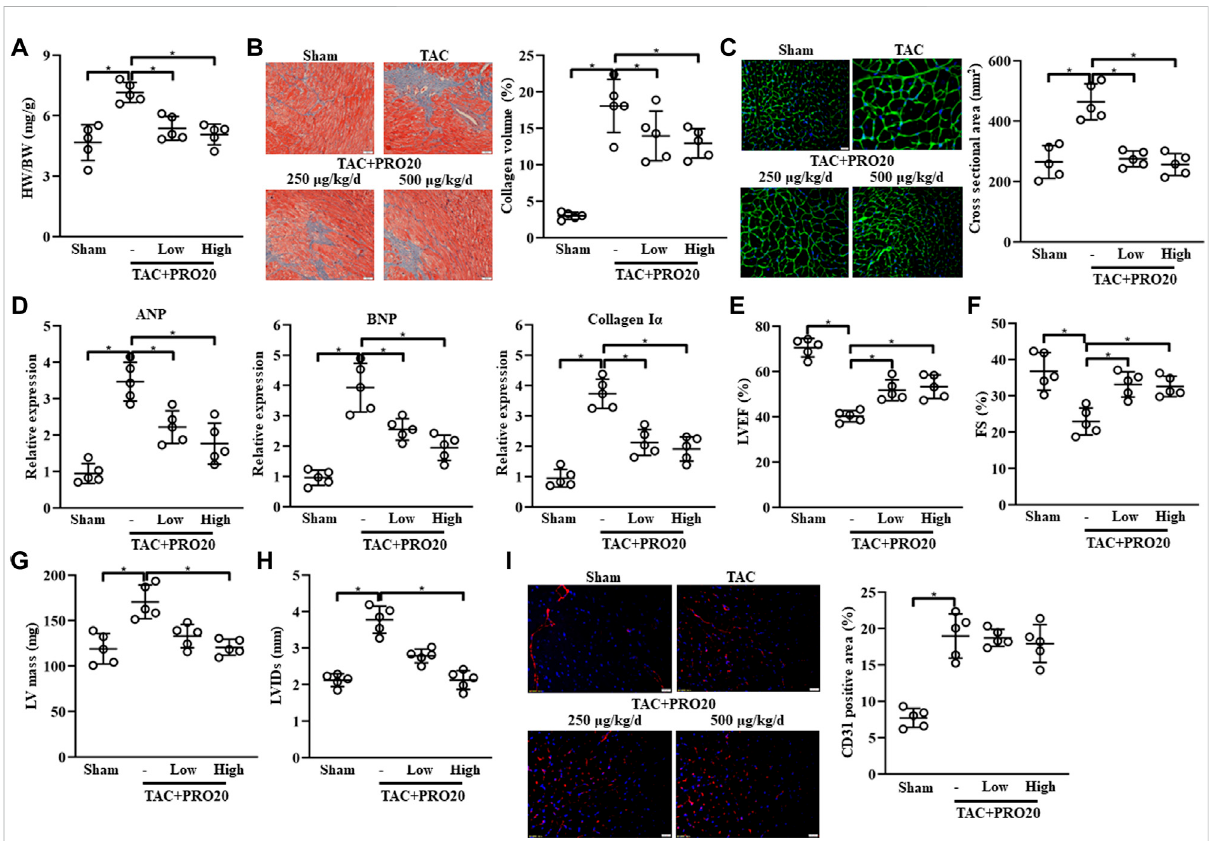
FIGURE 2 PRR decoy inhibitor PRO20 ameliorates HF in mice after 8 weeks of TAC surgery. (A) The ratios of heart weight and body weight (HW/BW) in TAC-inducedmice with and withoutPRO20 treatment for 8 weeks (250 μ g/kg/d and 500 μ g/kg/d). (B) Representative images of Masson staining of heart sections from TAC-induced mice and quantitative analysis of cardiac fi brosis. (C) Representative images of wheat germ-agglutinin (WGA) staining of heart sections from TAC-induced mice and quantitative analysis of cardiac hypertrophy. (D) Relative mRNA expression of cardiac hypertrophy markers (ANP and BNP) and Collagen I α in TAC-induced hearts with and without PRO20 treatment. (E – H) Echocardiographic analyses of left ventricular ejection fraction (LVEF), fractional shorting (FS), left ventricular mass (LV mass) and left ventricular internal diameter at end-systole (LVIDs)after8weeksofTACoperation. (I) RepresentativeimagesofCD31stainingofheartsectionsfromTAC-inducedmiceandquantitativeanalysis of angiogenesis. p p -value < 0.05. n = 5 per group. Data are expressed as mean ±